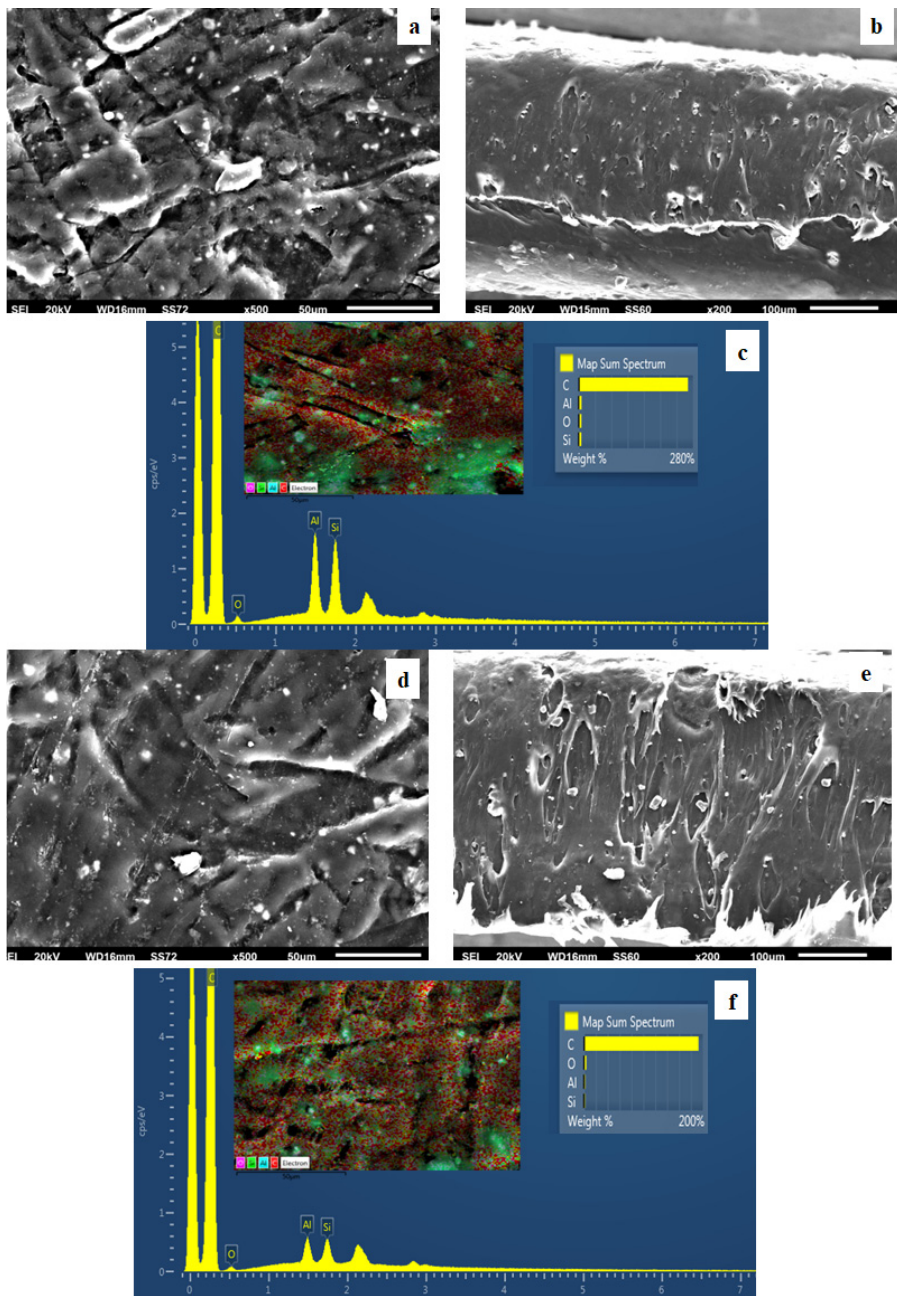
Figure 6. ( a , d ) SEM images of surface and ( b , e ) cross-section for the nanocomposite films of LDPE/10HNT ( a , b ) and LDPE/10TO@HNT ( d , e ), respectively. ( c , f ) Energy dispersive spectrometer (EDS) spectra, relative elemental analysis, and mapping of the surface from the SEM images at x1000 magnification.